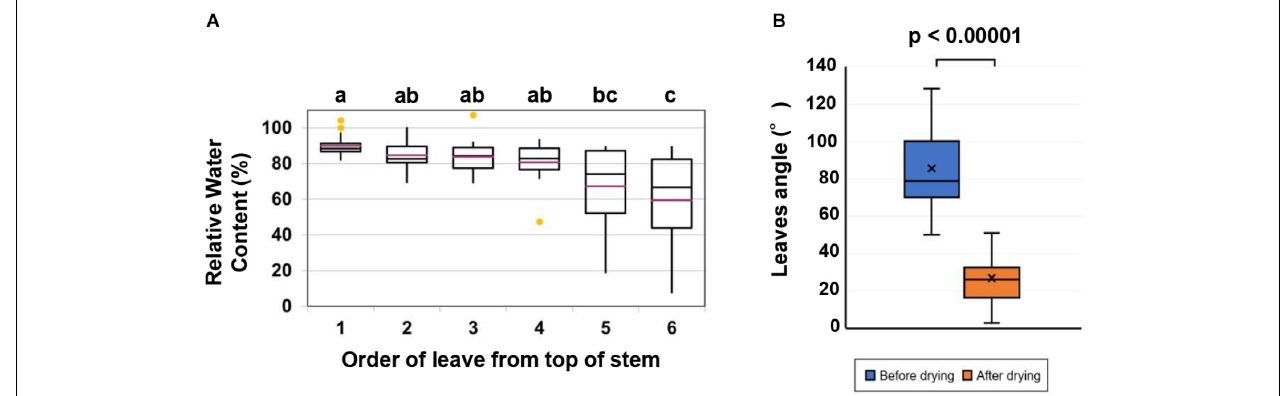
FIGURE 1 | Quantification of leaf wilting and relative water content (RWC) in leaves. (A) RWC in the first six leaves from the top of the stem of cassava plants subjected to drought tolerance by allowing the soil to dry. Data represent the mean ± SE ( n = 15). Different superscripted letters (a, b and c) within the column indicate statistically significant differences among the treatments determined by conducting a Scheffe multiple comparison ( P < 0.05). (B) Comparison of the leaves angle before and after the drought. A paired t -test indicated a significant change after the drying process ( n = 30 leaves, p < 0.00001).